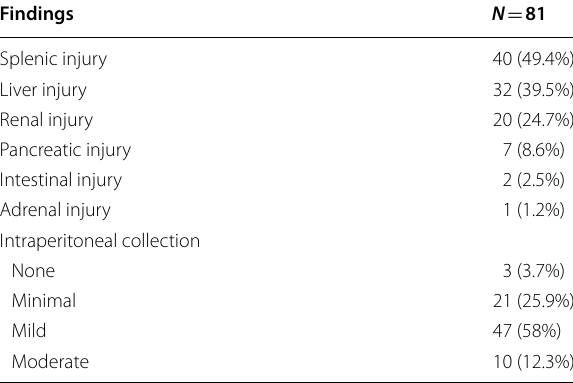
Data were expressed in form of frequency (percentage)